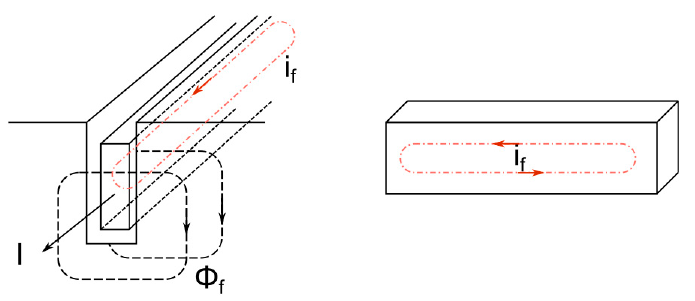
Figure 5. Leakage flux in the bar. Eddy current i f .